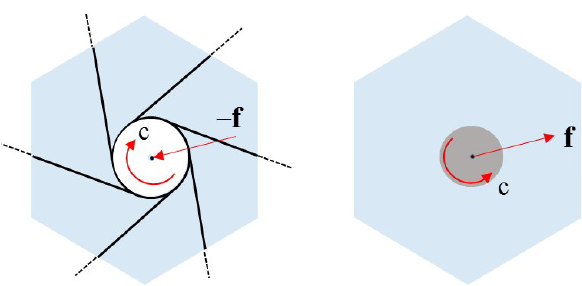
Figure 4: Contact force and couple between the rigid ring and the internal